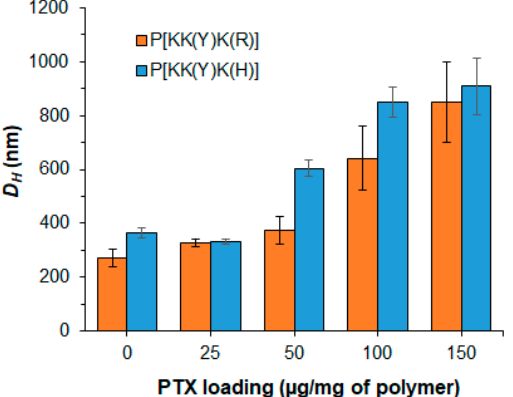
Figure 2. Effect of PTX loading into polypeptide nanoparticles on the hydrodynamic diameters of the delivery systems.